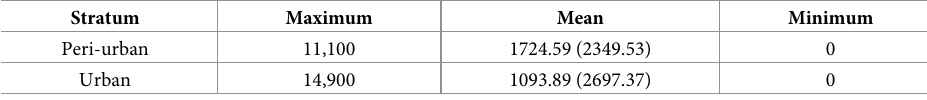
Figures in parentheses are the standard deviations.